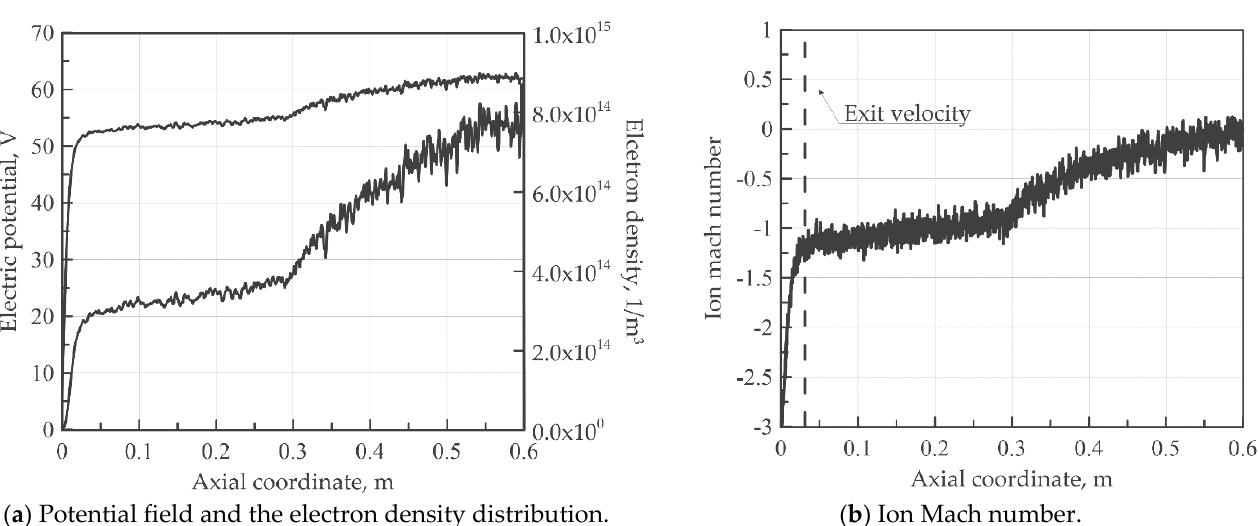
Figure 10. Results of the helicon double-layer thruster.